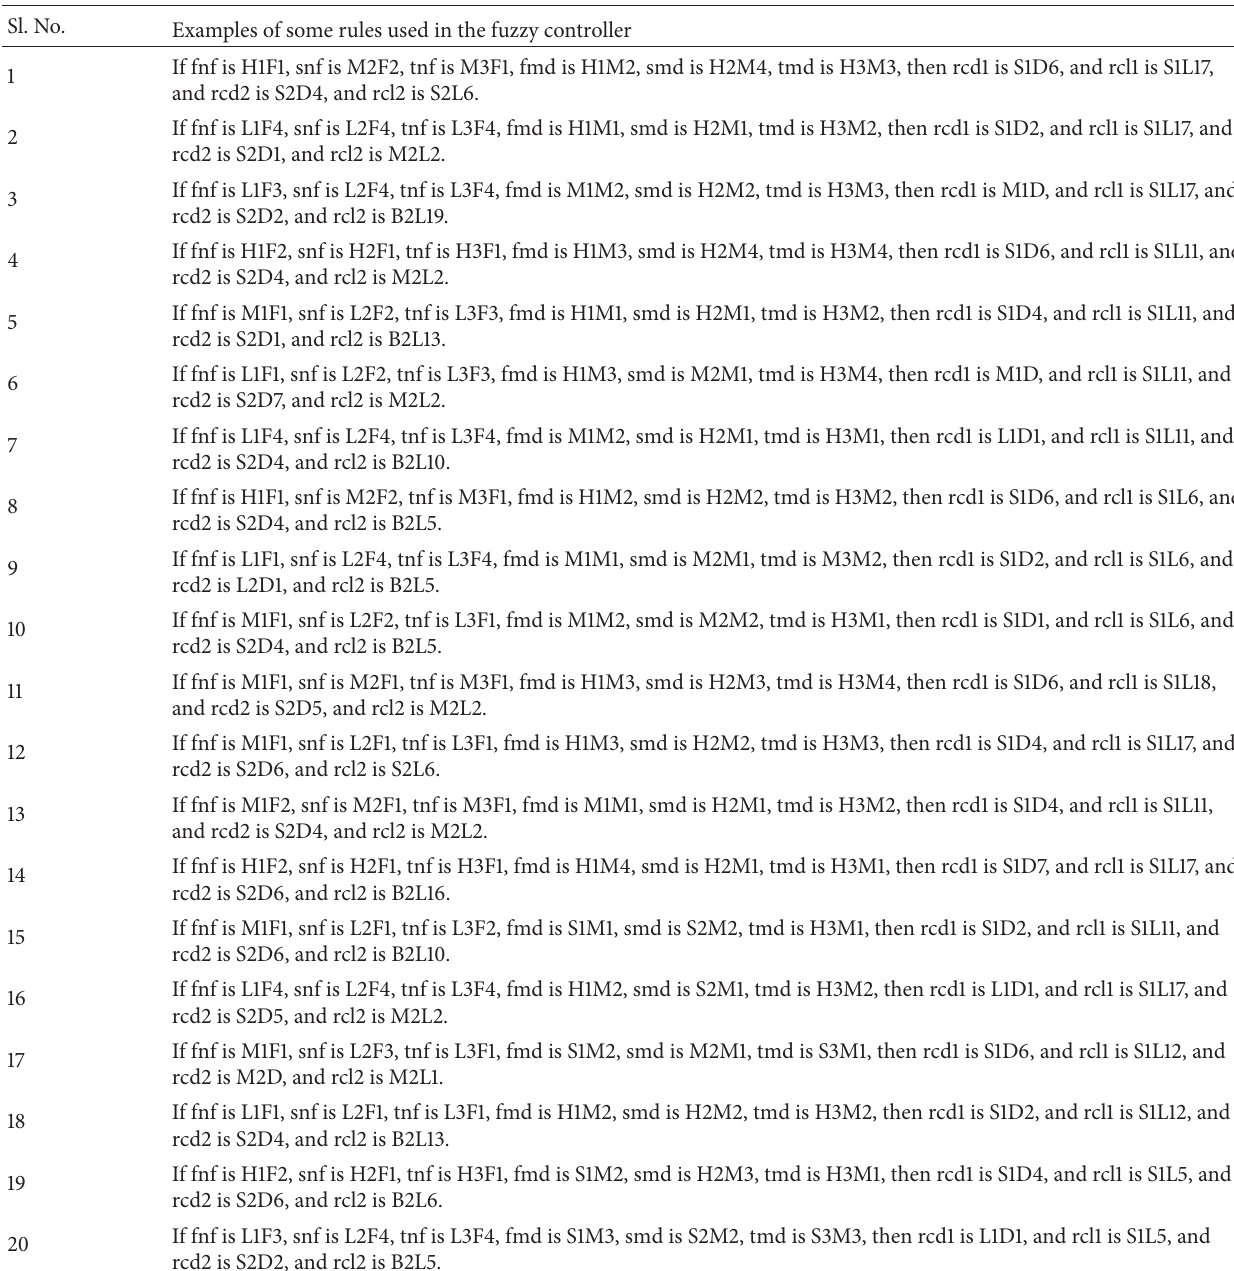
Table 2: Examples of twenty fuzzy rules used in fuzzy controller.